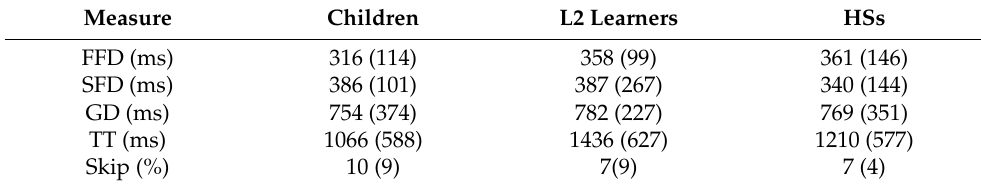
Table 3. Means (SDs) for the FFD and skipping probability measures for three groups of